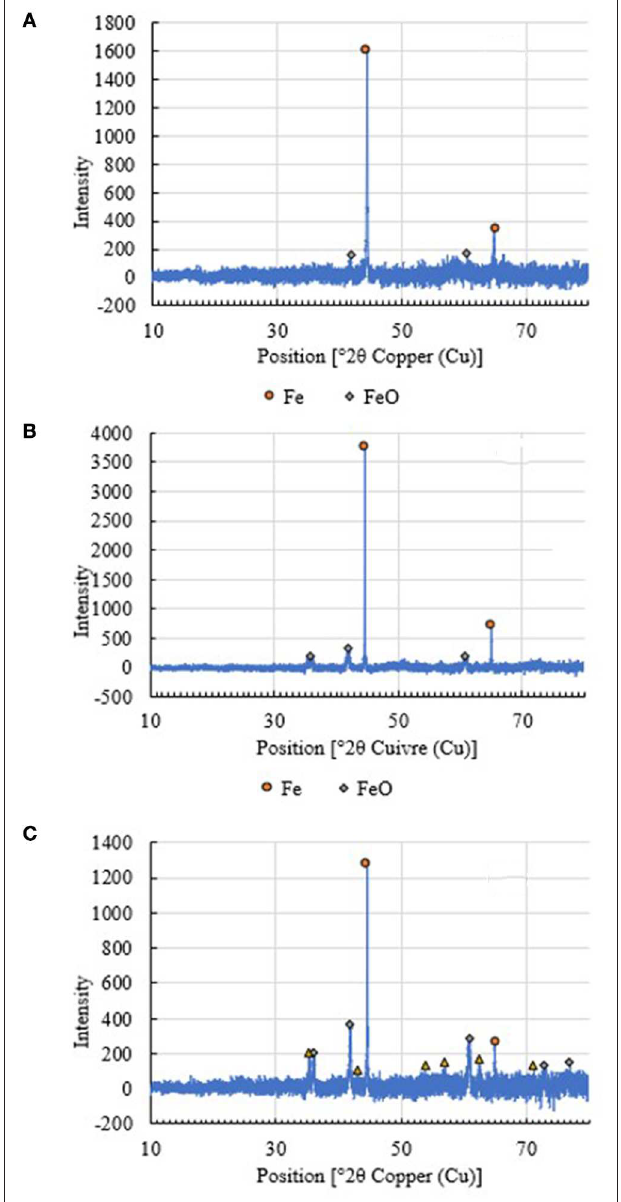
FIGURE 9 | Diffractograms of the solid products from biomass gasification with iron oxide: (A) 75w% biomass and 25w% iron oxide, (B) 50w% biomass, and 50w% iron oxide, (C) 34w% biomass and 66w% iron oxide.